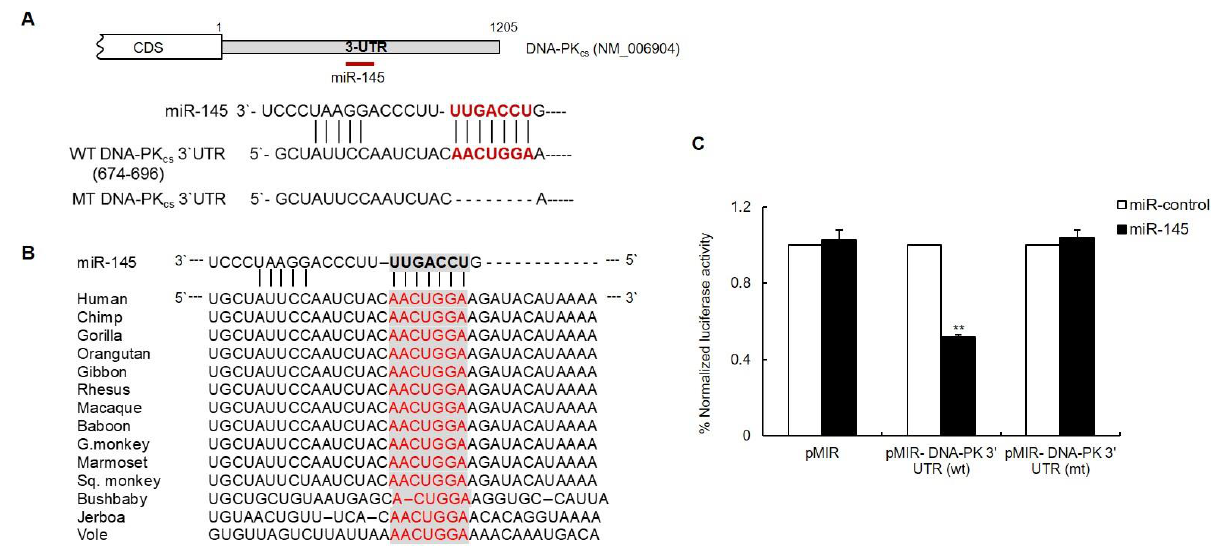
Figure 2. The 3 (cid:48) -UTR of DNA-PK cs is targeted by miR-145. ( A ) A schematic diagram of the predicted miR-145-binding sites in the 3 (cid:48) -UTR of DNA-PK cs mRNA. MT-DNA-PK cs has a deletion of seven bases at the 3 (cid:48) -UTR (red). ( B ) Alignment of DNA-PK cs 3 (cid:48) UTR sequences from fourteen vertebrate species. A conserved miRNA-mRNA interaction site, identified based on a seed sequence complementary to miR-145 nucleotides 1–8 (8-mer), is highlighted using gray boxes. ( C ) Luciferase reporter vectors carrying wild type or mutant 3 (cid:48) UTR of DNA-PK cs were co-transfected with either miR-145 or a control miRNA into HeLa cells. Luciferase activity was measured 24 h after transfection. Data is represented as the mean ± SD ( n = 3); **, p < 0.01.